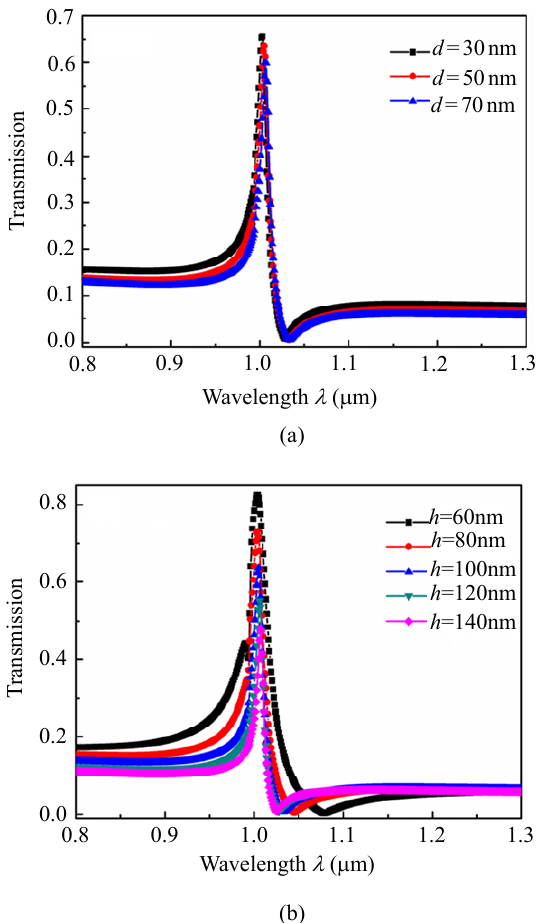
Fig. 6 Transmission spectra of the MIM waveguide coupled with two rings and rectangular cavities with (a) changing d ( h = 100 nm) and (b) changing h ( d = 50